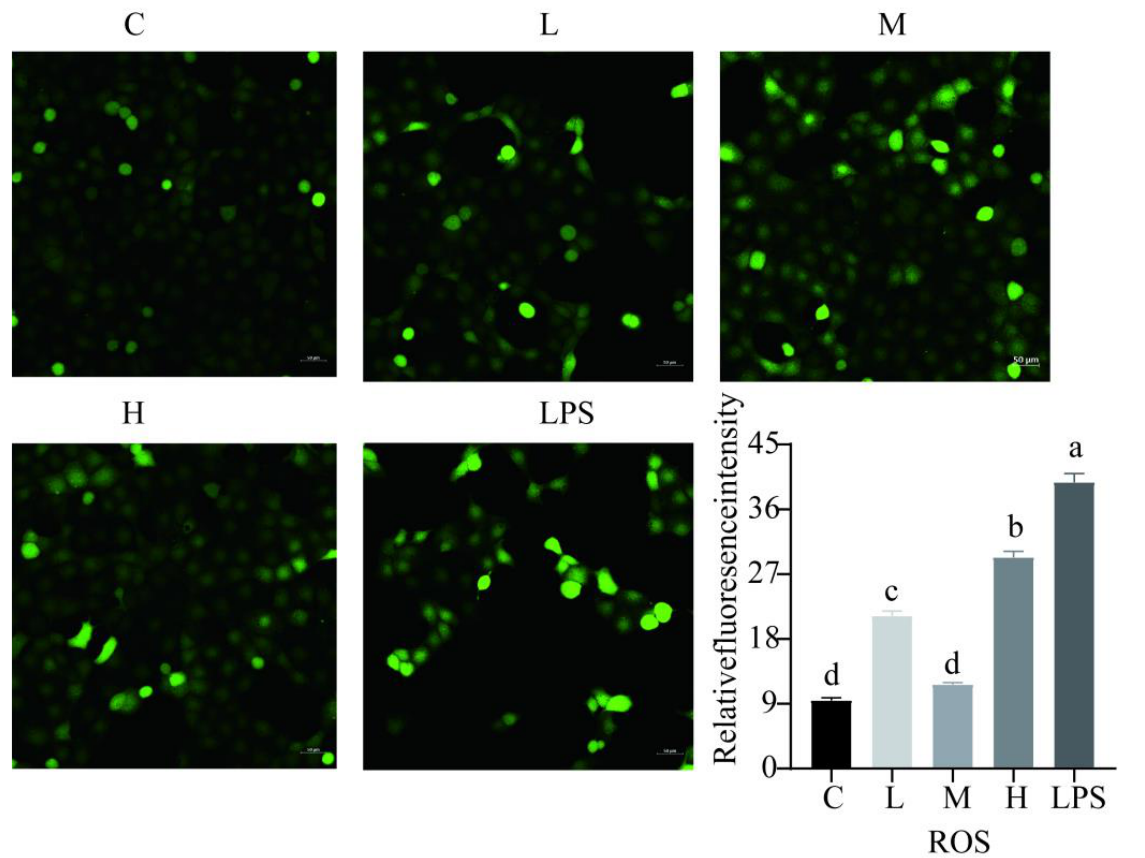
Figure 2. Effects of L. rhamnosus CY12 on the intracellular concentrations of ROS levels in LPS-induced Caco-2 Cells. Note: C represents uninduced Caco-2 cells; L, M, and H represent LPS-induced Caco-2 cells co-incubated with 10 7 , 10 8 , and 10 9 cfu/mL L. rhamnosus CY12, respectively; LPS represents LPS-induced Caco-2 cells. Data were presented as mean ± SEM. Means with the different letters are significantly different p < 0.05. The magnification of these picture is 100X, and scale bar is 50 µm. Intracellular ROS showed green fluorescent light in the microscope.